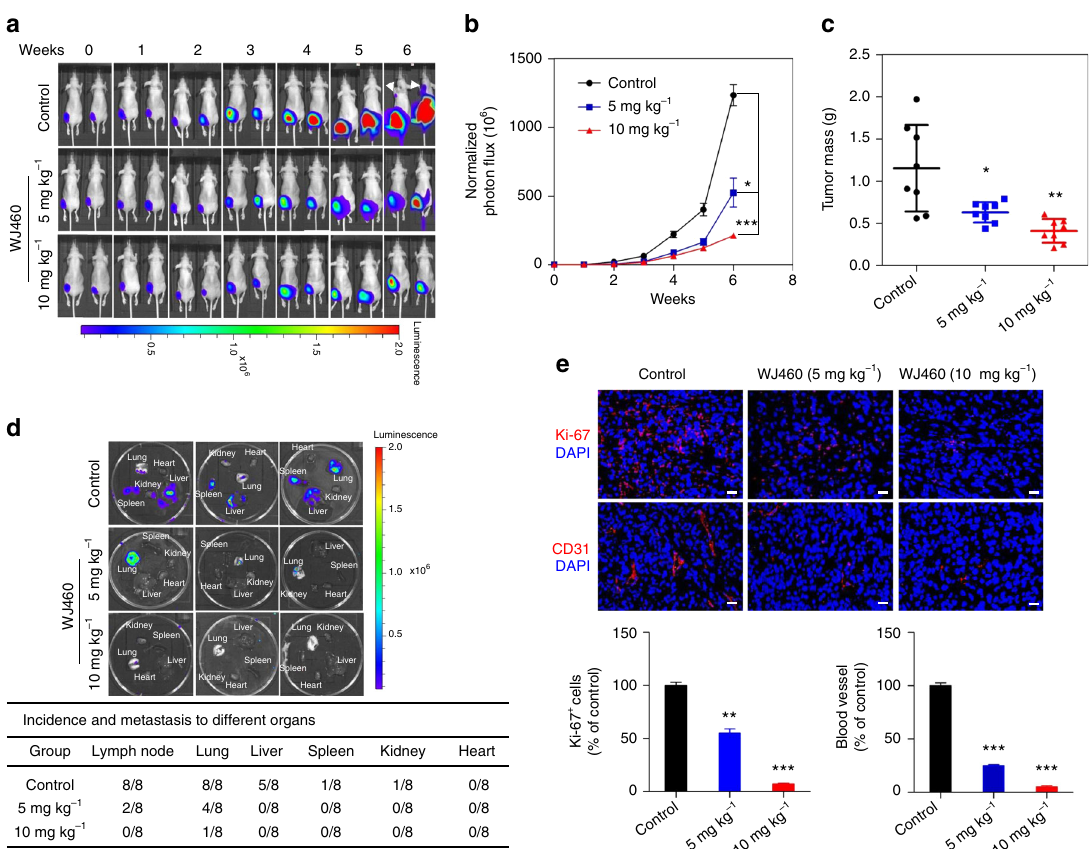
Fig. 2 WJ460 exhibits potent antitumor activity in a spontaneous metastasis mouse model. a MDA-MB-231-Luciferase cells were implanted orthotopically in the mammary fat pad of female nude mice. When the tumor was palpable (day 7), mice were allocated into different groups according to the initial bioluminescence ( n = 8). DMSO or WJ460 was administered intraperitoneally. Tumor growth was monitored weekly. Arrows, lymph node metastasis. b Quanti fi cation of bioluminescence. Data shown are mean ± s.d. * p < 0.05, *** p < 0.001. c When the experiment was terminated, all mice were sacri fi ced and the primary tumor was dissected and weighed. * p < 0.05, ** p < 0.01. d Major organs were imaged for tumor presence shortly after harvesting. e Primary tumor sections were stained for Ki67 or CD31. Nuclei were counterstained with DAPI. Positive cells and blood vessel density were analyzed by the IPP software. Scale bars, 10 μ m. Data shown are mean ± s.d. ** p < 0.01, *** p <